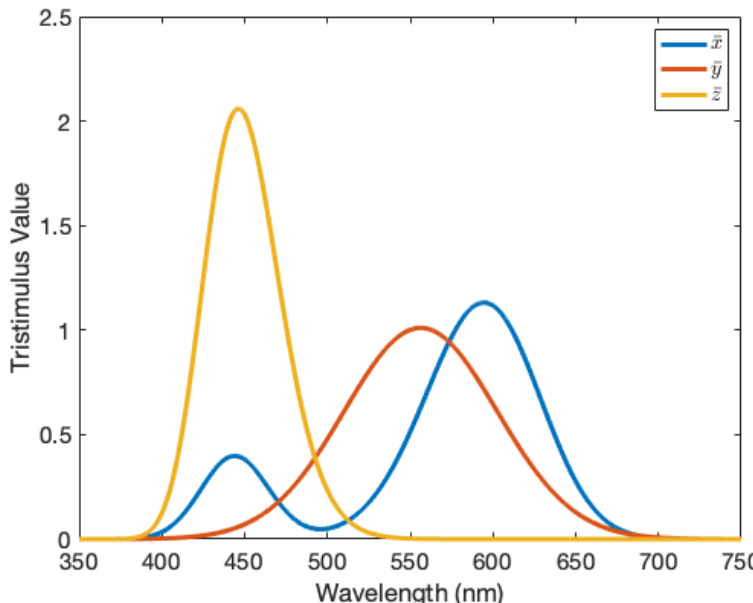
Figure 6. The colour matching functions ¯ x ( λ ) , ¯ y ( λ ) and ¯ z ( λ ) of the standard illuminant D65 for a standard colourimetric observer